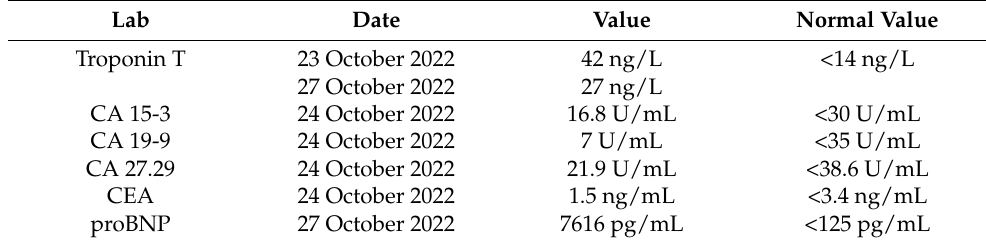
Table 1. Patient lab results and reference ranges.